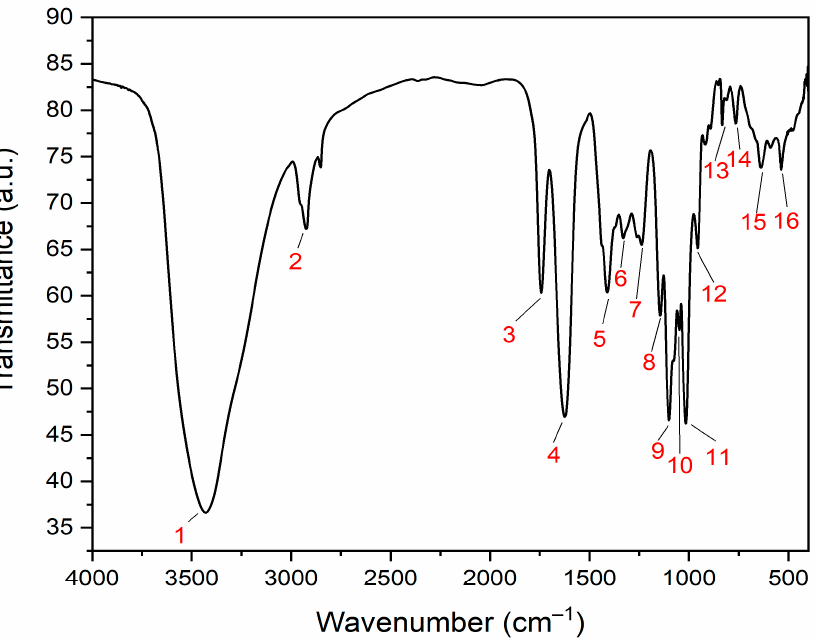
Figure 8. FTIR spectrum of ZnO-NPs (The numbers referred to the wavenumber of different bands (peak 1: 3429.94 cm − 1 ; peak 2: 2924.56 cm − 1 ; peak 3: 1742.31 cm − 1 ; peak 4: 1624.74 cm − 1 ; peak 5: 1410.06 cm − 1 ; peak 6: 1329.53 cm − 1 ; peak 7: 1237.50 cm − 1 ; peak 8: 1145.03 cm − 1 ; peak 9: 1100.92 cm − 1 ; peak 10: 1048.07 cm − 1 ; peak 11: 1014.87 cm − 1 ; peak 12: 956.94 cm − 1 ; peak 13: 832.32 cm − 1 ; peak 14: 765.06 cm − 1 ; peak 15: 638.89 cm − 1 ; peak 16: 535.65 cm − 1 ). Table 1. Functional groups of ZnO-NPs detected by FTIR analysis.